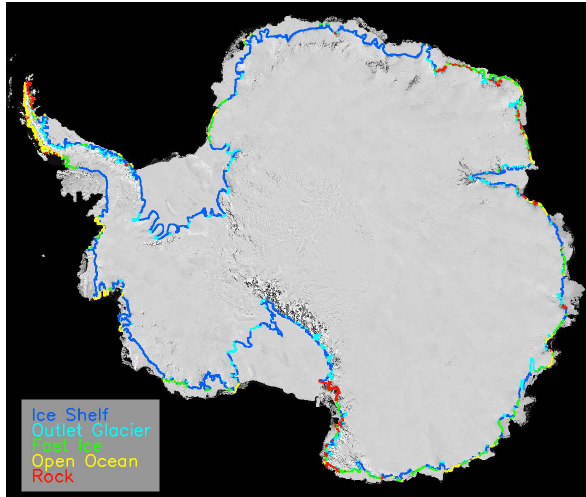
Figure 4. The ASAID grounded ice boundary displayed on the Landsat Image Mosaic of Antarctica. Line color represents the type of transition for ice transiting the grounded ice boundary. The corresponding percent frequencies of occurrence are: Ice Shelf (dark blue, 61%); Outlet Glacier (cyan, 13%); Fast Ice (green, 10%); Open Ocean (orange, 9%); and Rock (red, 7%).